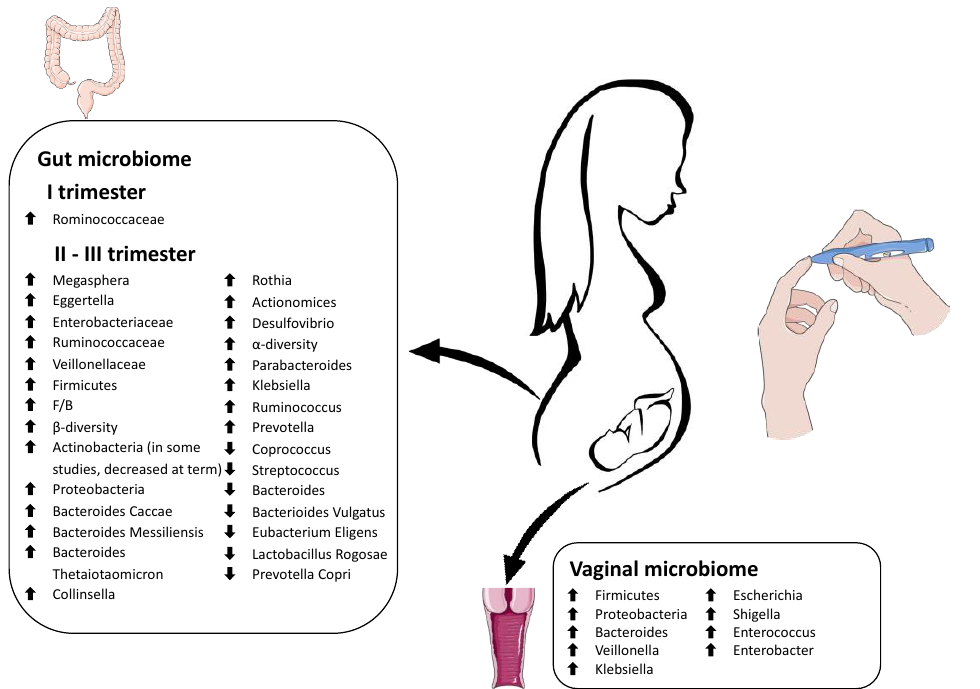
Figure 3. Schematic representation of the main alterations in the maternal microbiome in pregnancies complicated by gestational diabetes. The Figure was partly generated using Servier Medical